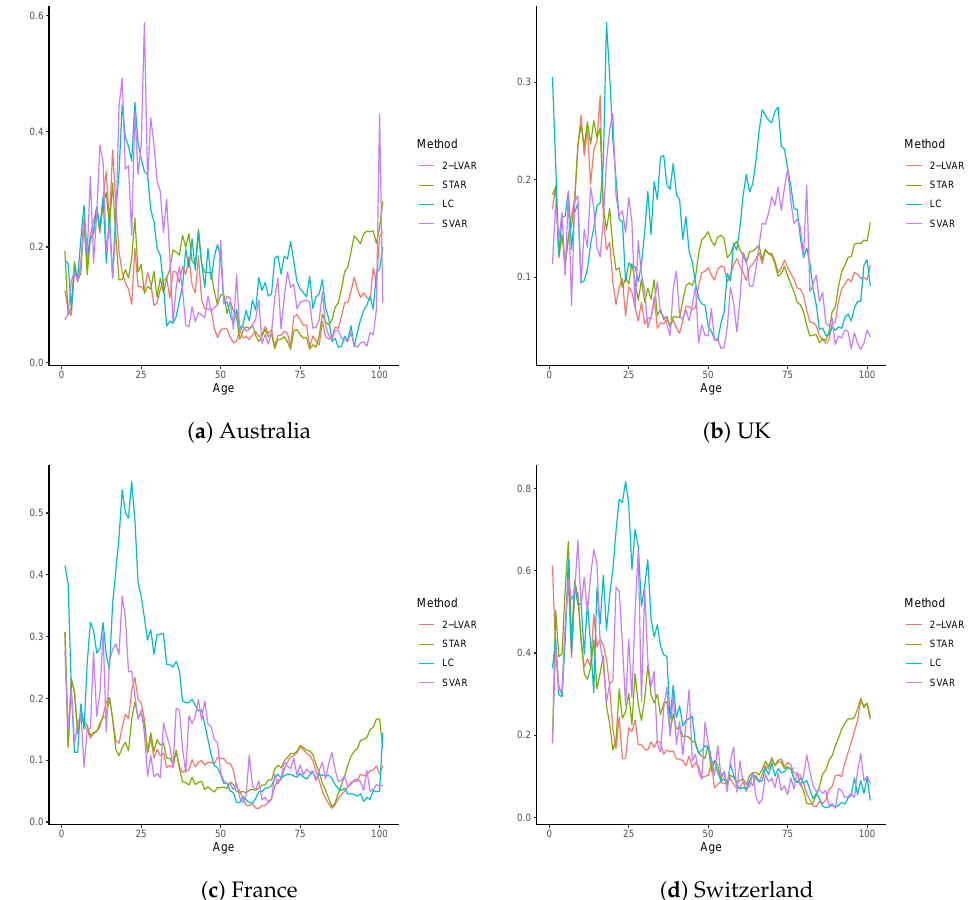
Figure 2. RMSE over age groups for mortality data of Australia, the UK, France, and Switzerland. The training sample includes 1950–2000, and the test sample includes 2001–2016. The age group includes 0–100. The compared models are LC, STAR, SVAR, and